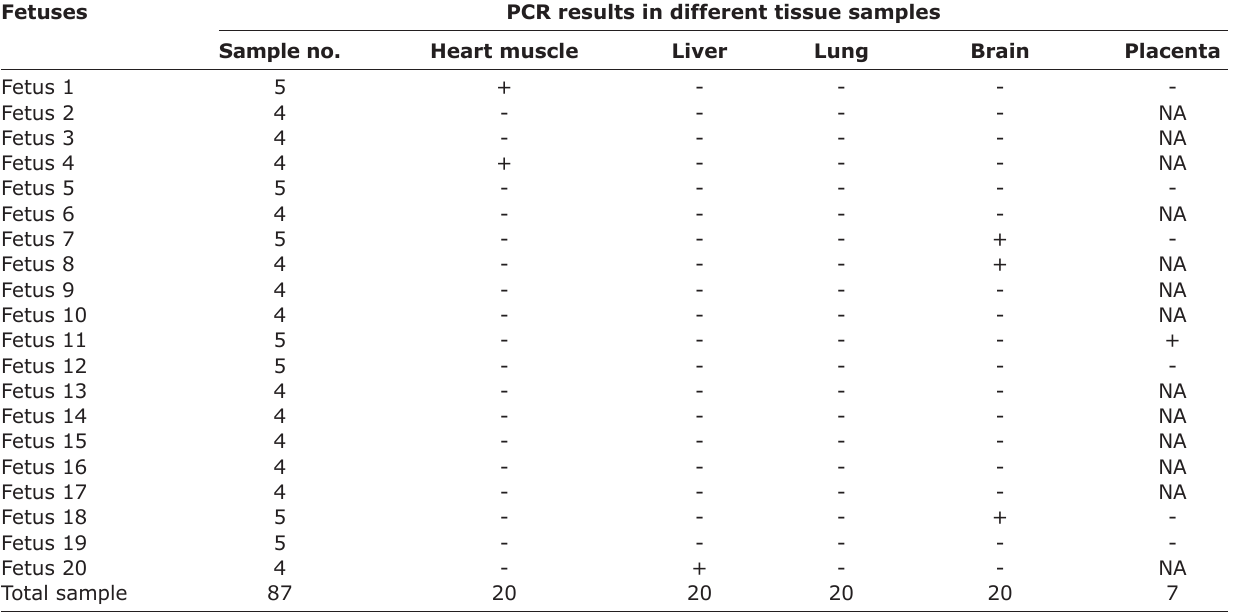
Table-3: Toxoplasma gondii in different tissue samples based on PCR assay.